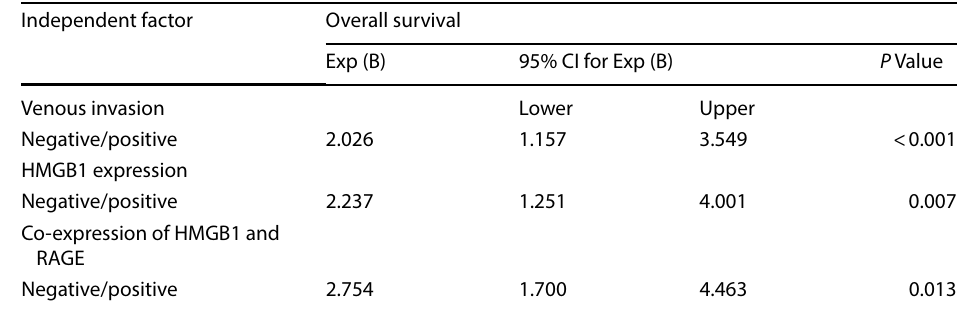
Table 7 Survival analyses by multivariate Cox regression